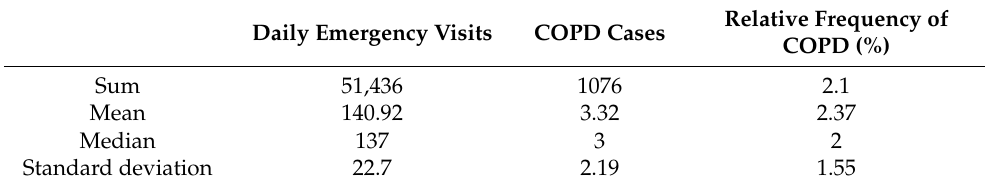
Table 3. Descriptive statistics of the daily emergency department visits and the COPD